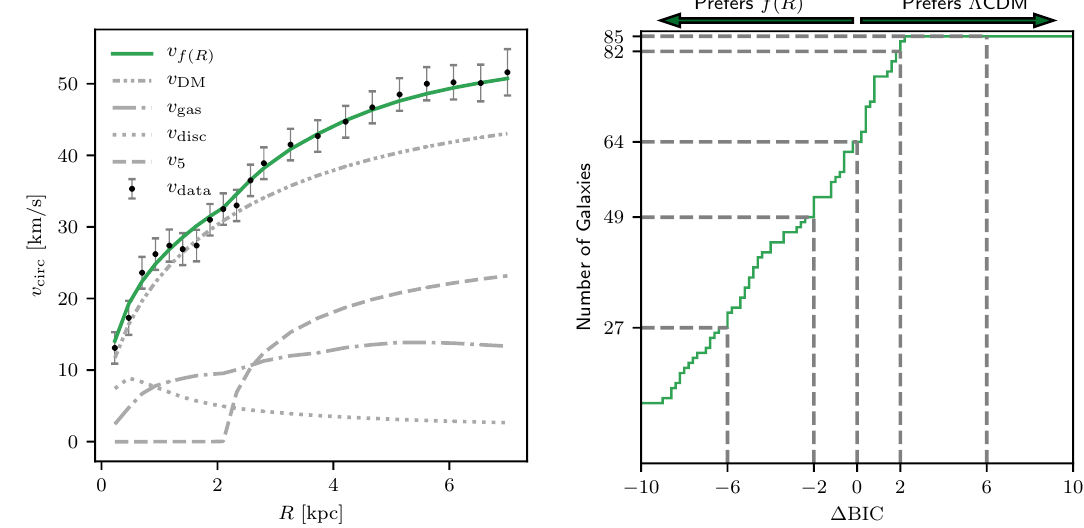
Figure 27. Left panel : rotation curve of NGC 3741 and the corresponding best fit with chameleon- f ( R ) gravity combined with a cuspy NFW dark-matter halo (green curve). The grey lines show the contributions of the different galactic components to the f ( R ) -model as labelled. Right panel : Cumulative distribution function of ∆ BIC , where BIC is the Bayesian Information Criterion, across SPARC galaxies. Most galaxies in the sample prefer the f ( R ) model, but not necessarily with the same value of the model parameters. The figure is reproduced from